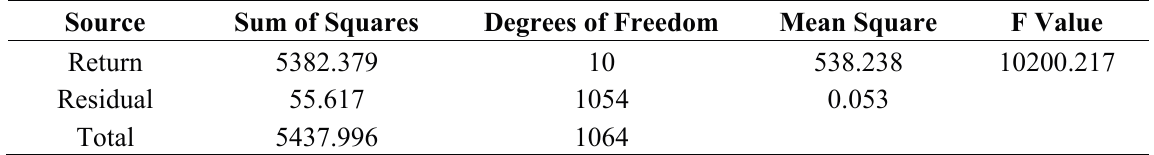
Table 5. Analysis of variance